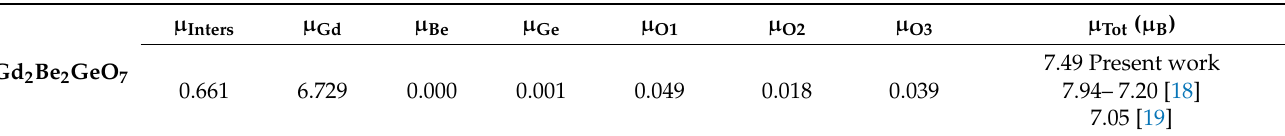
Table 3. Calculated magnetic moments of each atom, interstitial, and cell for Gd 2 Be 2 GeO 7 compound in µ B unit compared to experimental